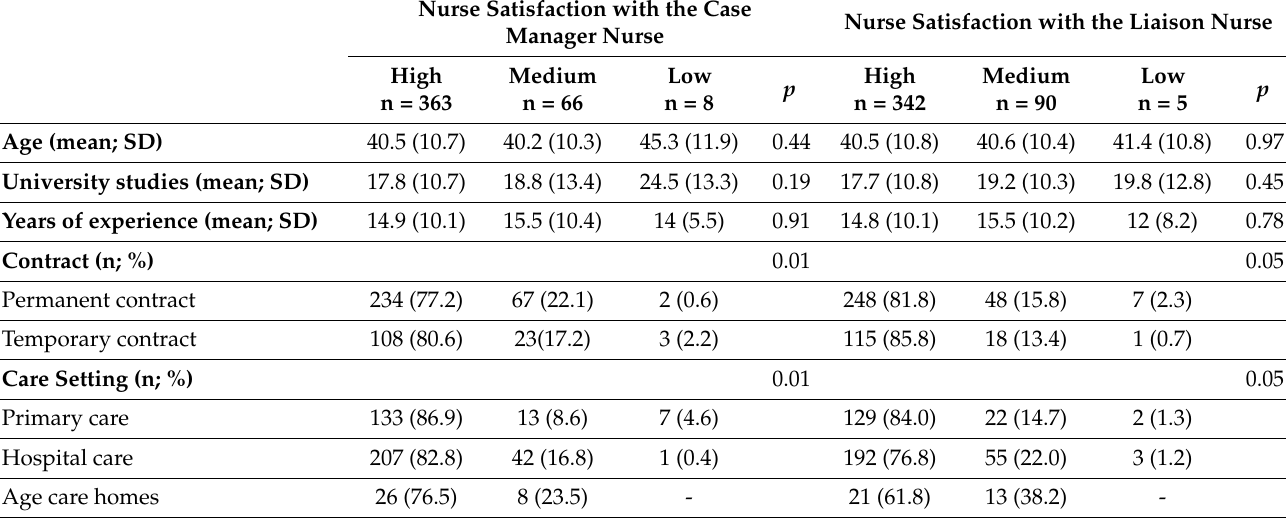
Table 3. Satisfaction with case manager nurses by socio-demographic and employment variables. Nurse Satisfaction with the Case Nurse Satisfaction with the Liaison Manager Nurse